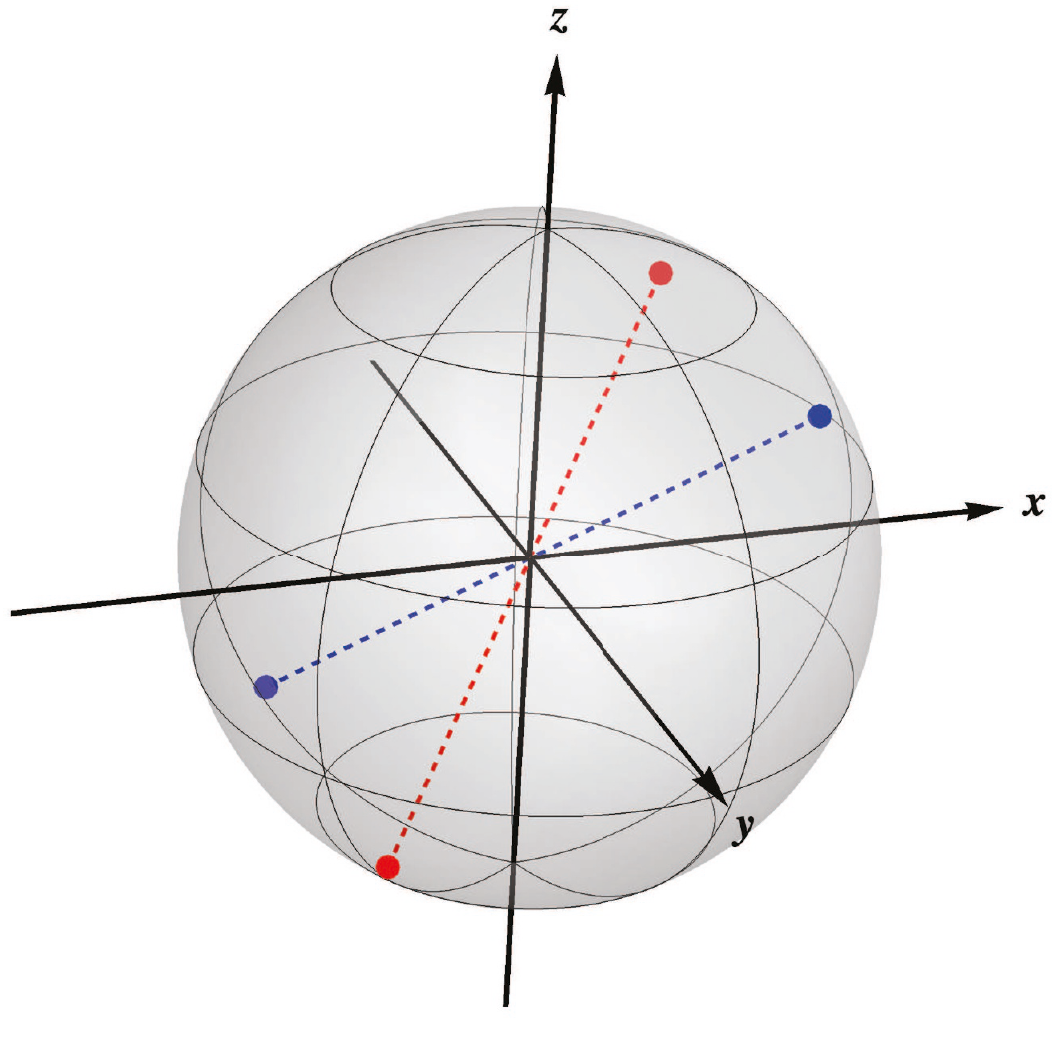
Figure 5. Illustration of Minkowski pairs on the surface of a sphere. The sphere is split into eight octants and two distinct Minkowski pairs lying in different octants are shown. The red dots represent a Minkowski pair solution r = (1 / √ 3 , which lies in the fourth and sixth octants of the sphere, while the blue dots represent a Minkowski pair solution r = (1 / √ 3 , 1 / √ 3 , 1 / √ 3) and ¯ r = ( seventh octants of the